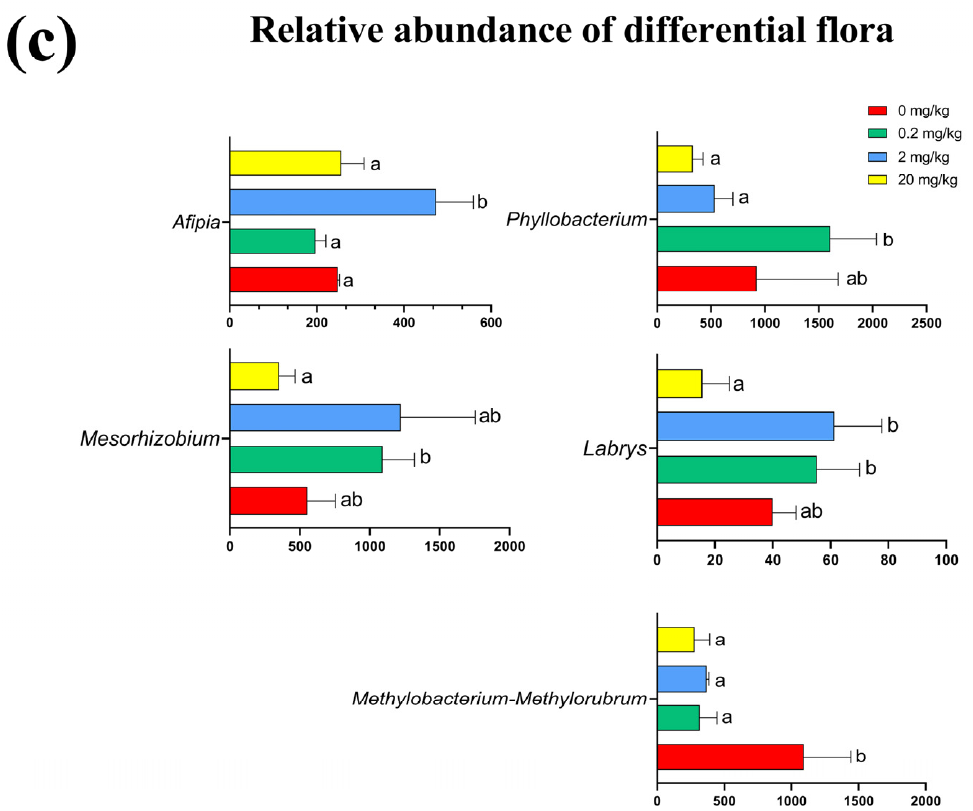
Figure 2. Relative abundance of the primary bacterial genera in the intestine of C. carpio grouped by KM treatment: ( a ) microbial community analysis (genus); ( b ) microbial community heatmap analysis (genus); sample A: 0 mg/kg; B: 0.2 mg/kg; C: 2 mg/kg; D: 20 mg/kg; each bar corresponds to an individual fish; bacterial classes showing a relative abundance <1% were designated as “others”; ( c ) the relative abundance of different flora in the intestine. Different superscript letters indicate significant differences for each pairwise comparison between treatments ( p < 0.05).